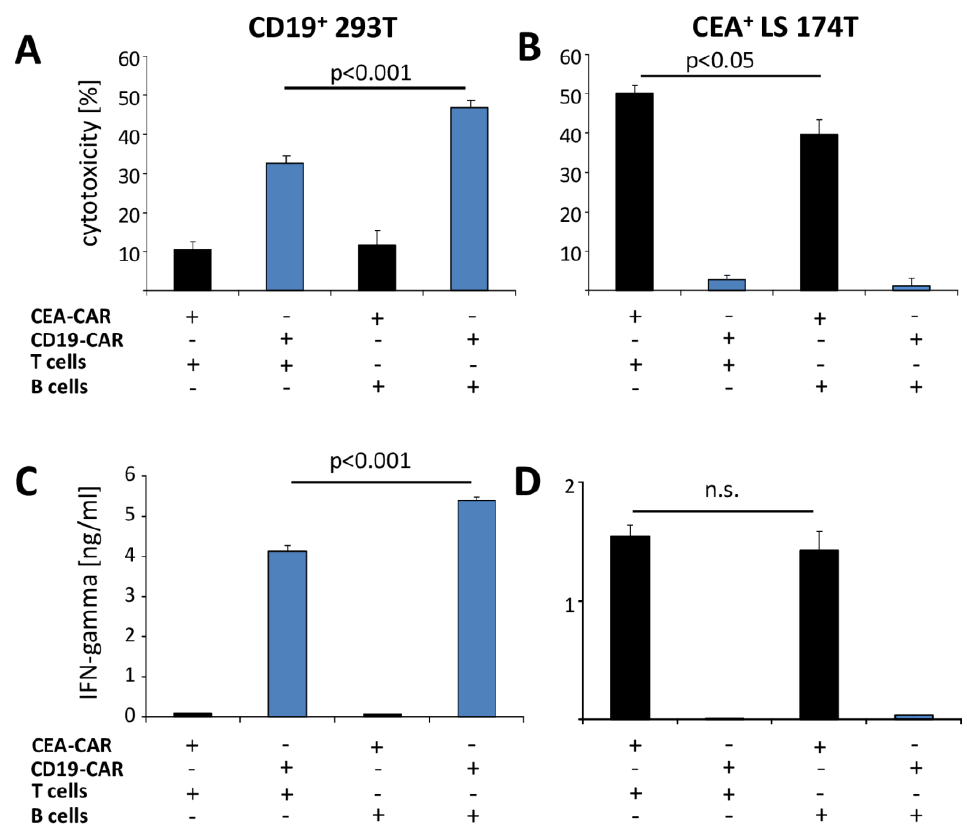
Figure 1. Pre-incubation with the autologous B cells improves a CD19-CAR T cell attack against CD19 + target cells. Autologous B and T cells were flow sorted utilizing anti-CD20 and anti-CD3 mAbs, respectively, and co-incubated (1:10) with CD19-CAR T cells (blue columns) for 72 h; CEA-CAR T cells served as control. CAR T cells were recovered and co-incubated (5 × 10 4 cells/well) for 48 h with engineered CD19 + CEA − HEK293T ( A , C ) or CD19 − CEA + LS 174T ( B , D ) cells as targets for the respective CAR (each 2.5 × 10 4 cells/well), respectively. ( A , B ) Viability of the tumor cells was determined by the XTT assay and specific cytotoxicity was calculated. ( C , D ) IFN- γ in the culture supernatant was recorded by ELISA. Data represent mean values of triplicates ± SD. Significant differences were determined by Student ’ s t test; n.s. = not significant.